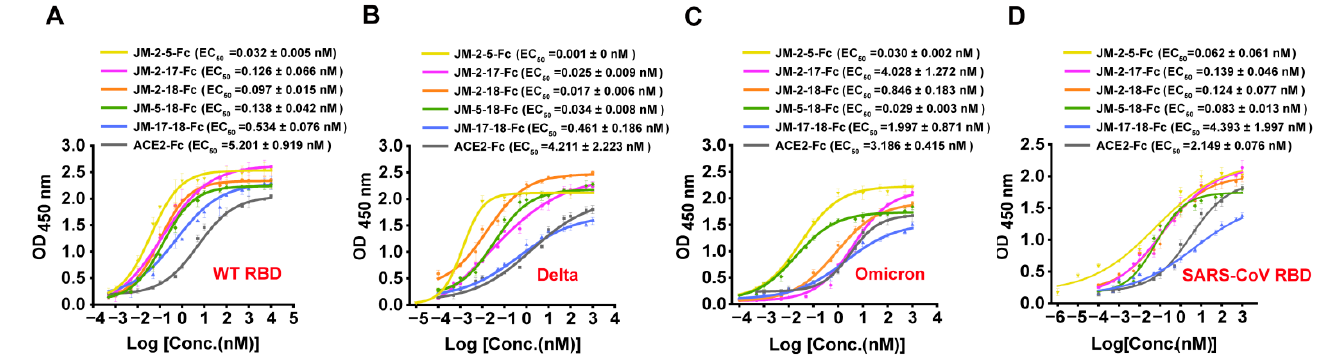
Figure 10. Binding characterization of bi-paratopic VNARs to various RBD by ELISA. ( A – D ) The binding of bi-paratopic VNAR-Fc fusions to the RBD of WT ( A ), Delta ( B ), Omicron ( C ), and SARS-CoV ( D ). Error bars indicate means ± SD of three independent experiments. The EC 50 was calculated by fitting the OD 450 values from serially diluted VNAR-Fc fusions or ACE2-Fc to a sigmoid dose–response curve.